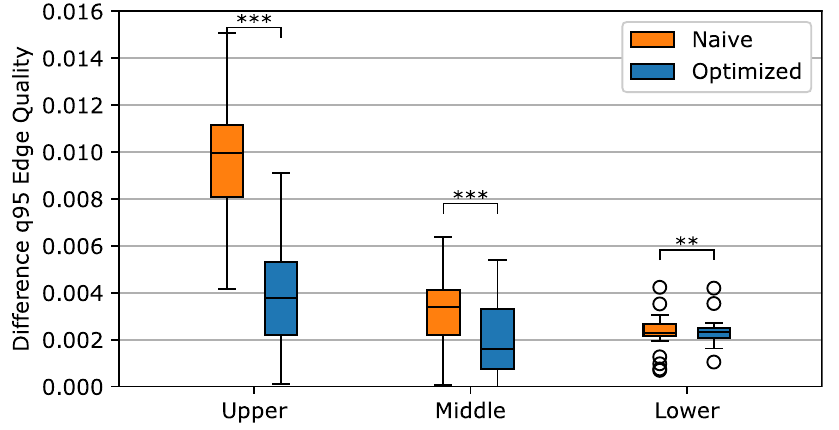
Fig 5. Difference in q95 edge quality between real and naive (orange bars, Naive) and real and optimized data (blue bars, Optimized). Four corresponding images are compared, and the results for the normalized z-indices are grouped into the upper, middle, and lower